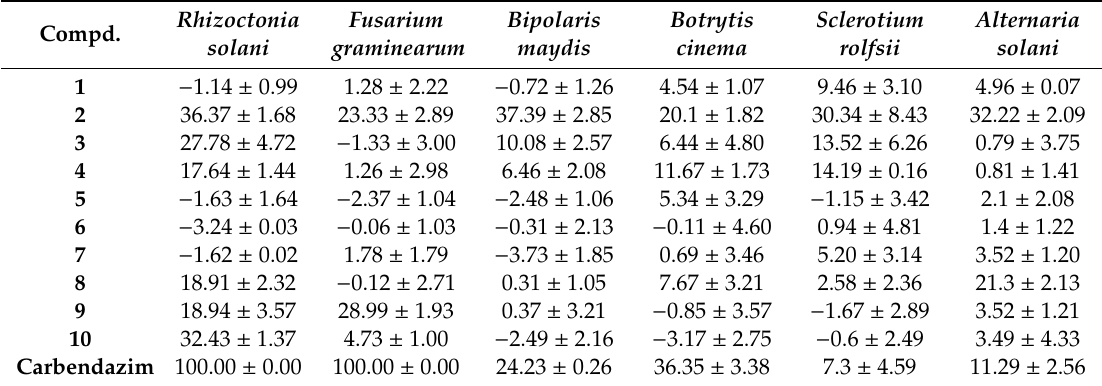
Table 1. Inhibitory ratio of 10 compounds against six phytopathogenic fungi (Inhibitory ratio ± SD, %).